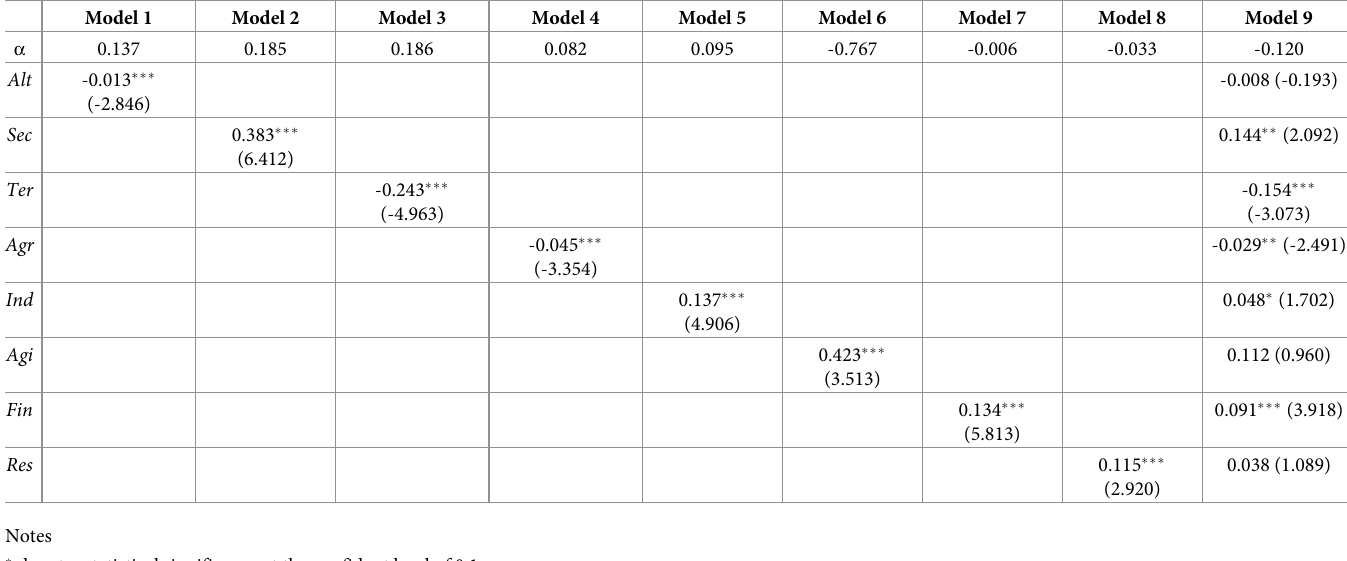
Table 6. OLS regression of factors affecting regional shrinkage of the three northeastern